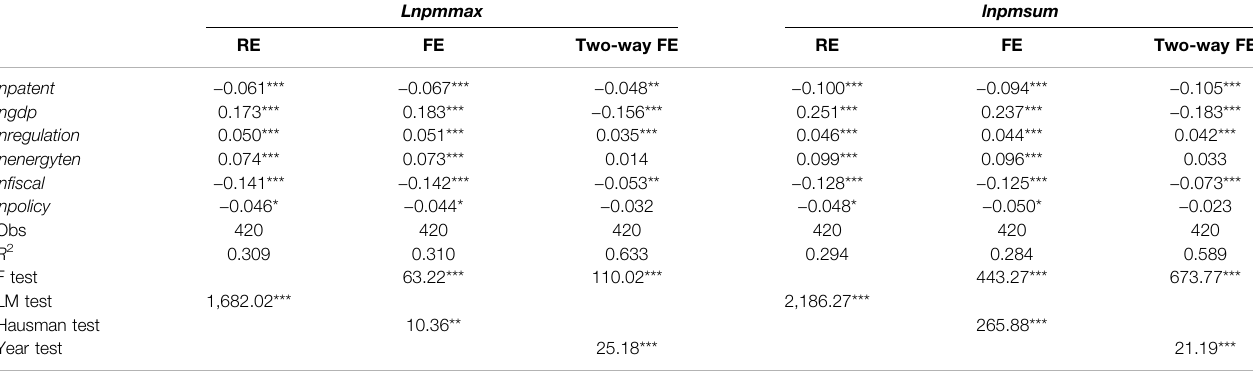
TABLE 4 | Robustness test results with lnpmmax and lnpmsum